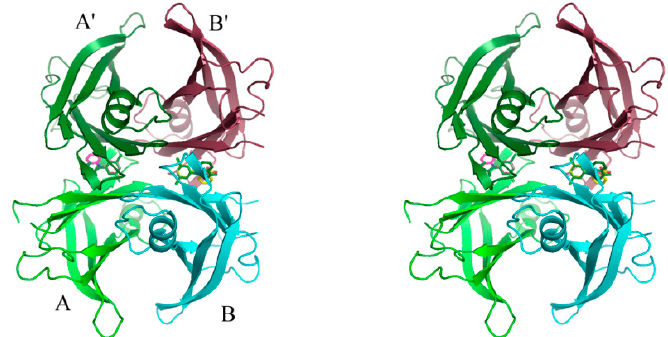
Figure 1. Stereo α -carbon representation of the human transthyretin (hTTR) quaternary structure showing the two independent monomeric subunits A and B (green and cyan) forming the 2-fold related hormone binding site, A (cid:48) and B (cid:48) (forest and raspberry). The compound of interest, VCP-6, is shown in the binding site with 60% occupancy.